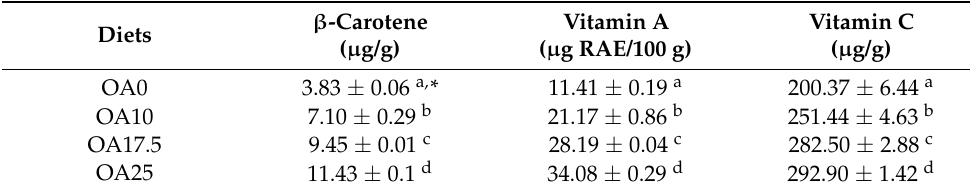
Table 4. Content of Tenebrio molitor larvae fed for six weeks with wheat bran (control) (OA0) and bran fortified with different rates of albedo orange peels waste (10 (OA10), 17.5 (OA17.5), and 25% (OA25)) in β -carotene, vitamin A, and vitamin C (n = 9). β -Carotene Vitamin A Vitamin C Diets ( µ g/g) ( µ g RAE/100 g) ( µ g/g) OA0 3.83 ± 0.06 a, * 11.41 ± 0.19 a 200.37 ± 6.44 a OA10 7.10 ± 0.29 b 21.17 ± 0.86 b